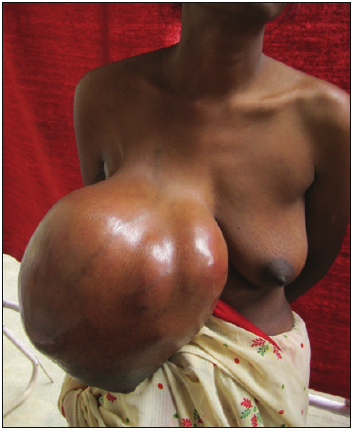
Figure 1: Anterior view of the tumour.